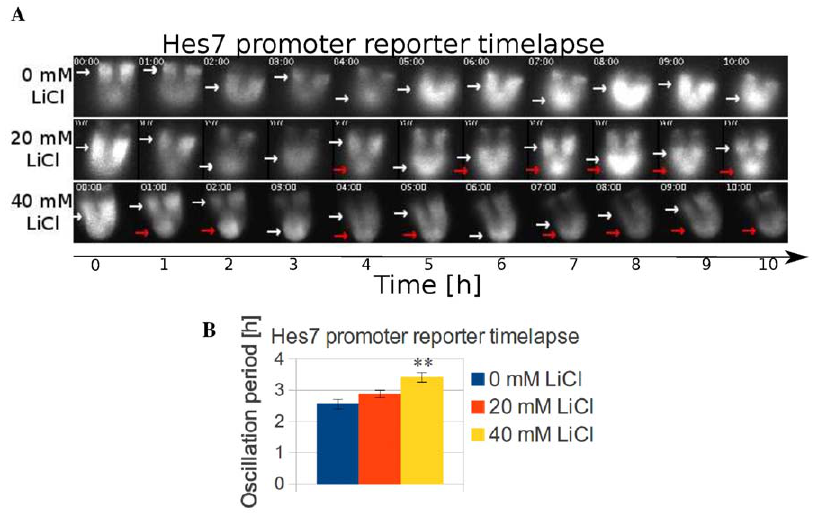
Figure 4. Lengthening of the oscillatory period of the Hes7 promoter activity by LiCl. (A,B) Timelapse imaging of E10.5 Hes7 promoter luciferase reporter embryos in the presence of 20 and 40 mM LiCl and period quantification. The control sample shows the oscillatory promoter activity bands (White arrows), while the 20 and 40 mM LiCl-treated samples show an abnormal posterior band (Red arrows) (A). Quantification shows an increase of the oscillation period in a dose-dependent manner for the control (n=11), 20 mM LiCl (n=12) and 40 mM LiCl (n=4) of 2.5 h, 2.9 h and 3.6 h (B).